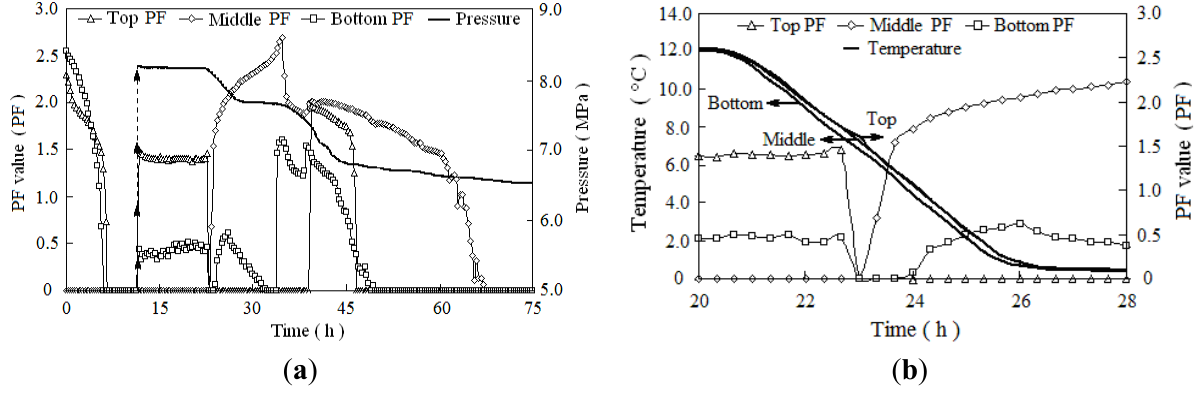
Figure 3. Parameter changes during methane hydrate formation process in the layered medium: top coarse sand layer, middle loess layer and bottom coarse sand